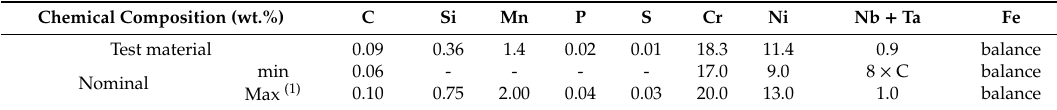
Table 1. Composition of TP347HFG stainless steel from Sumitomo Metal Industries LTD (Tokyo, Japan). Chemical Composition